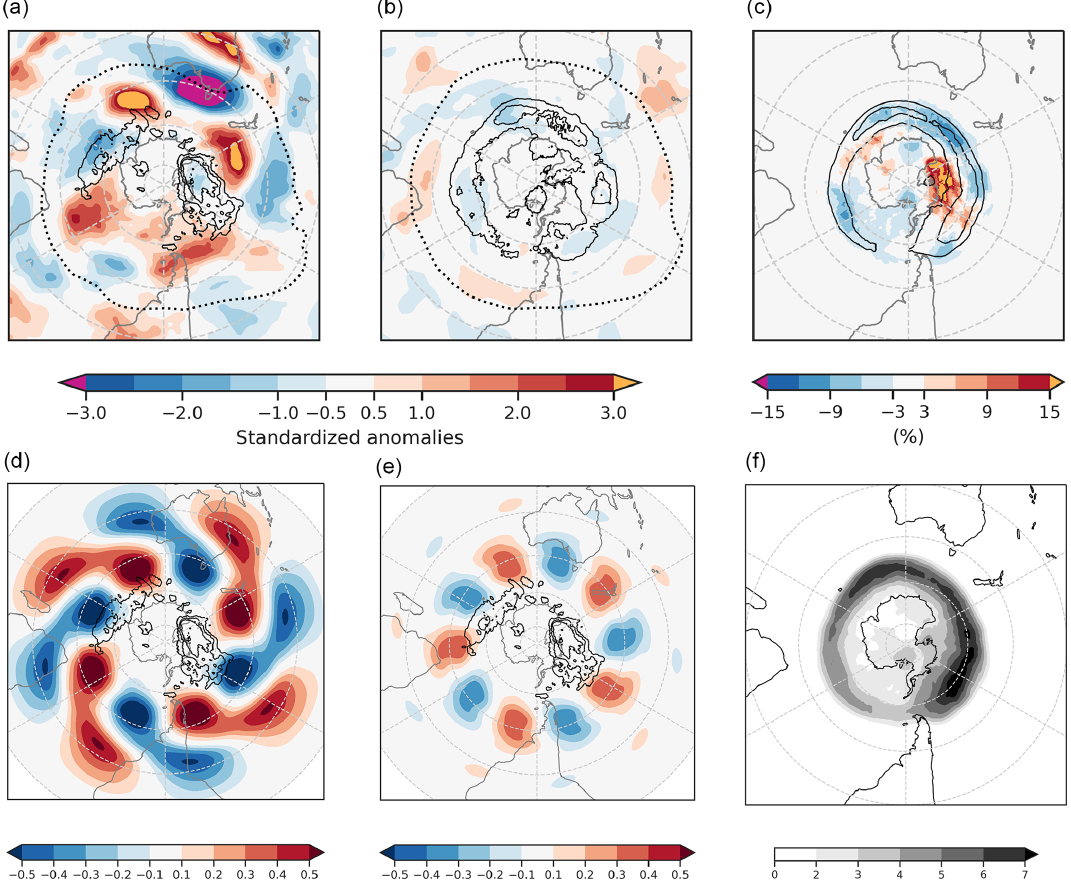
Figure 8. Standardized PV anomalies on the 350K isentrope with respect to the DJF climatology (1979–2018) for (a) high- R SEA days and SEA heatwave days (HDs) and (b) high- R SEA days and non-SEA HDs. Dotted black lines show a 2PVU contour in the mean PV fields for panels (a) and (b) , and black contours show mean blocking frequency contours at 5%, 10%, and 15% for the same. (c) The difference in blocking frequency between panels (a) and (b) . (d) The WN4 and (e) WN5 component for the mean PV (in PVU) for high R SEA and SEA HDs in panel (a) , with black contours showing the blocking frequency as in panel (a) . (f) The climatological mean blocking frequency (%) for DJF; black contours in panel (c) show the same at 4% and